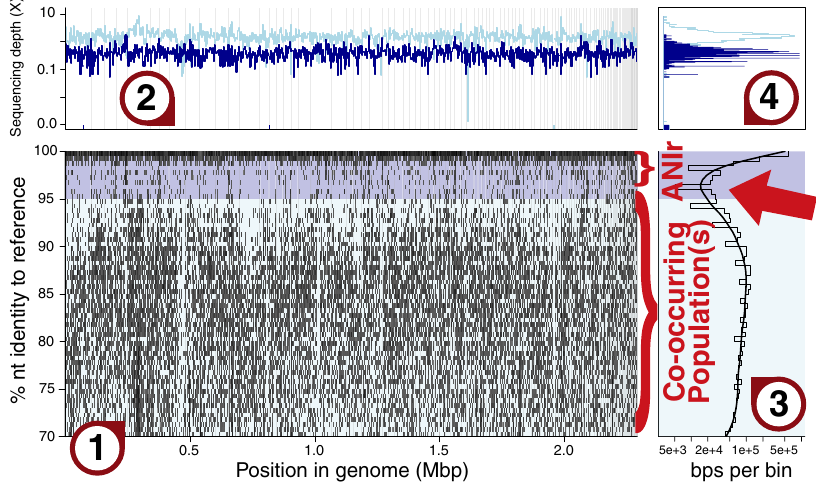
Fig. 1 Example of a read recruitment plot. This fi gure showcases the result of processing a Blastn search of metagenomic short reads (each matching read is represented by a dot in main panel 1) against a reference MAG sequence recovered from the same metagenome (x-axis). 1 Main panel representing the reads recruited (mapped), placed by location (x-axis) and identity (y-axis) across the reference sequence. 2 Sequencing depth (or coverage) across the reference, i.e., how many reads map at each base pair position, in logarithmic scale. Bars lower than the average represent regions with fewer mapped reads, which denote gene content differences. 3 Identity histogram of mapped reads per unit of identity (light gray) and smoothed spline (black), in logarithmic scale. 4 Sequencing depth histogram. Peaks based on the sequencing depth revealed in panel 2 are automatically identi fi ed as skewed normal distributions (in red). The background of panels 1 and 3 , and the line colors in panels 2 and 4 , correspond to matches with identity above (dark blue) and below (light blue) a user-de fi ned cutoff. By default, the identity cutoff is set to 95%. Note the area of sequence discontinuity denoted by a decrease, by more than one order of magnitude (x-axis, panel 3 ), in the number of reads mapping around 95% identity (red arrow) relative to reads mapping at >98% identity. ANIr is estimated based on reads in the dark blue area only and represents the average nucleotide identity of reads to the reference sequence. The MAG represents an uncultivated member of the Actinobacteria phylum that shows about 45% average amino acid (AAI) to Ilumatobacter coccineus , its closest related named species with available genome representative(s). The metagenome was obtained from a planktonic sample from 1000 m in the Gulf of